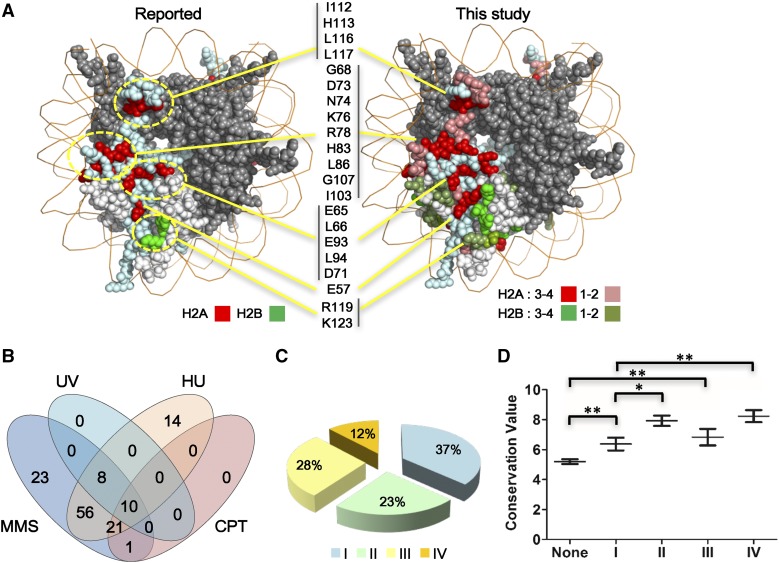
High-throughput phenotype analysis of a yeast library containing two copies of histone mutants. (A) More HU-sensitive mutants were identified with the BY-H2ML1&2 library. The reported mutants (Matsubara et al. 2007; Sakamoto et al. 2009) were marked in bright red for H2A and bright green for H2B. For BY-H2ML1&2, H2A/H2B mutants were marked with different red/green colors, indicating the strength of phenotype, which was defined by using a number from 1 to 4 (to indicate weak to strong phenotype). Bright red: H2A mutants with phenotypes classified 3 or 4. Russet-red: H2A mutants with phenotypes classified 1 or 2. Bright green: H2B mutants with phenotypes classified 3 or 4. Dull green: H2B mutants with phenotypes classified 1 or 2. If two or more mutants for a certain residue showed phenotypes, the highest phenotype degree of this residue was displayed. H2A R30 is not shown since it cannot be visualized at this angle. The S. cerevisiae nucleosome structure is used in the entire paper (PDB number: 1ID3). The locations of corresponding clusters of mutants in the nucleosome structure were marked with yellow lines and circles. (B) Venn diagram of mutants sensitive to different DNA damage-inducing stresses. (C) Statistical analysis of mutants with phenotypes according to their biological processes. See the classification of different stresses in Table S2 in File S1. I: mutants with one class of phenotype, blue; II: mutants with two classes of phenotypes, light green; III: mutants with three classes of phenotypes, yellow; and IV: mutants with four classes of phenotypes, orange. (D) Evolutionary conservation scores for mutants with different classes of phenotypes were calculated using ConSurf. The definition of phenotype numbers I–IV is the same as those in (C). Data were represented as mean ± SEM. * P < 0.05 and ** P < 0.01. CPT, camptothecin; MMS, methyl methanesulfonate; HU, hydroxyurea; UV, ultraviolet.